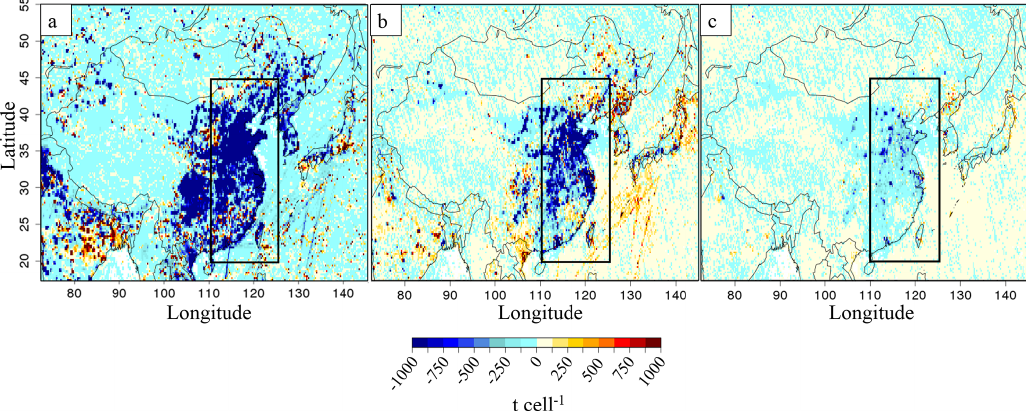
Figure 3. Annual differences between the EDGAR-HTAP-v2.2 inventories for the year 2010 and the emissions corrected from OMI for the year 2015, for (a) SO 2 , (b) NO and (c) NO 2 . Units are tons per cell (tcell − 1 ) (cell size of 0.25 ◦ × 0.25 ◦